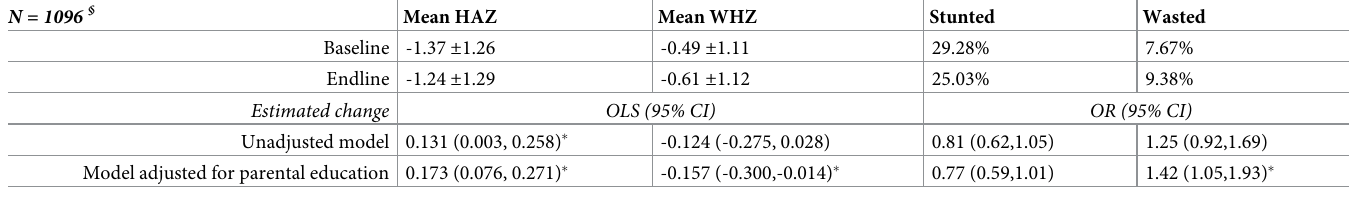
Table 3. Estimated changes in child nutritional status between baseline and endline (full sample).